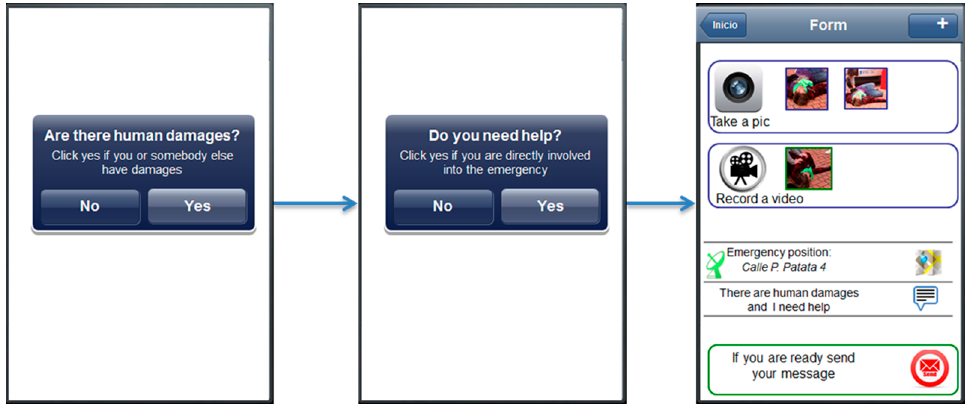
Figure 5. The mobile application after the re-design process.